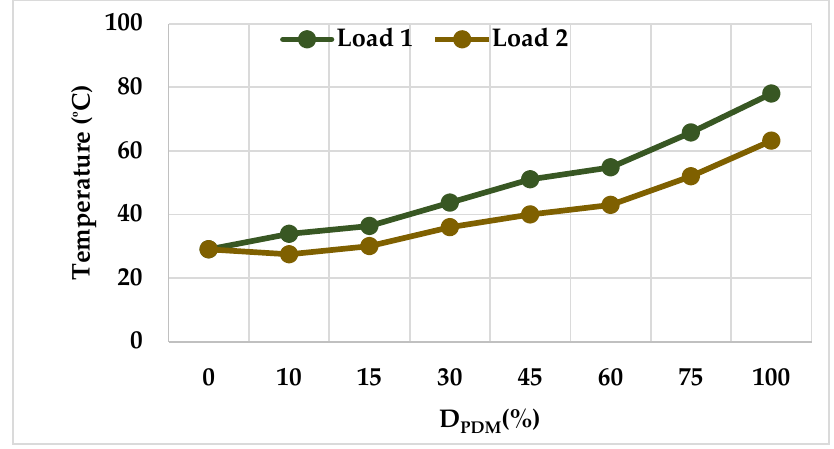
Figure 13. Variations of temperature with respect to D PDM.